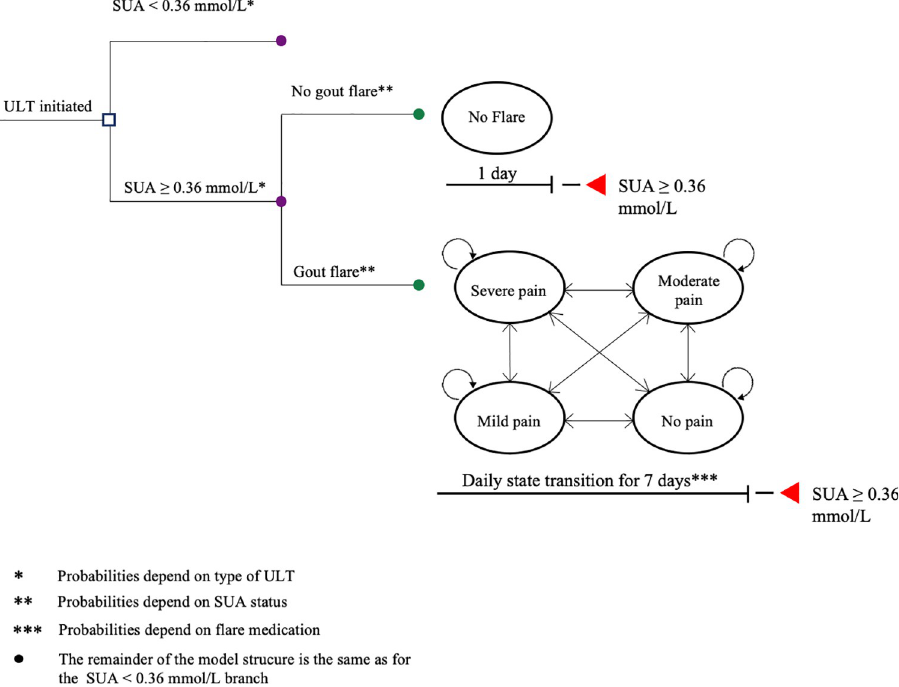
Fig 1. Model structure. ULT, urate lowering therapy; SUA, serum urate. � Probabilities depend on type of ULT; �� Probabilities depend on SUA status; ��� Probabilities depend on gout flare medication; • The remainder of the model structure is the same as for the SUA < 0 . 36 mmol/L